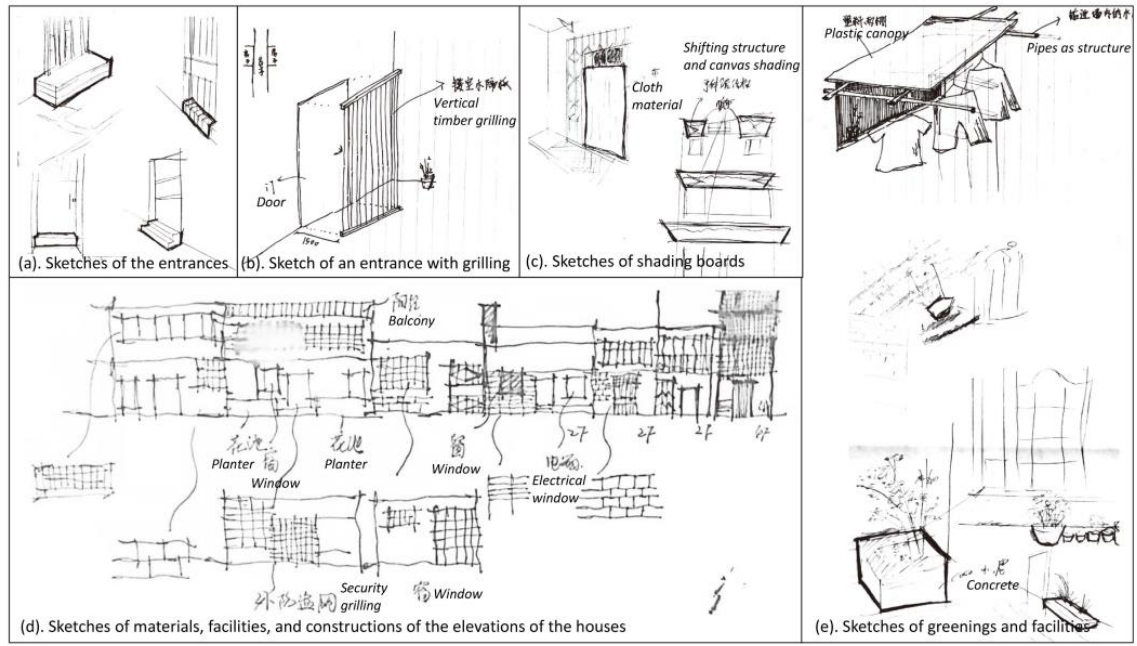
Figure 7. Sketches of the interaction items in the street (drawn by the students).